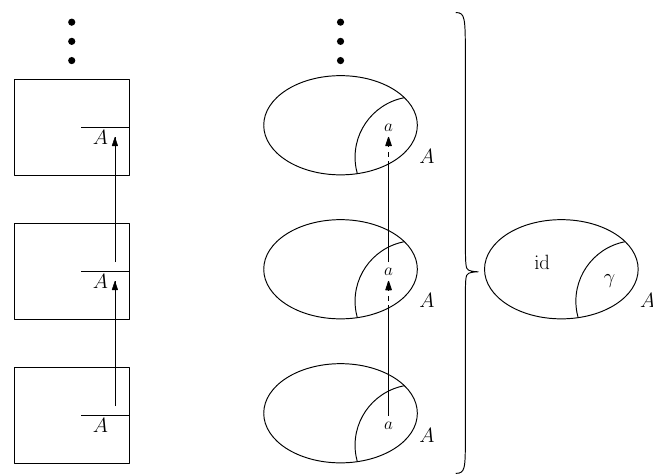
Figure 32 . Branched surfaces for the Rényi entropies. On the l.h.s. we show the gluing on the field theory side. On the r.h.s., a spatial slice of the bulk is